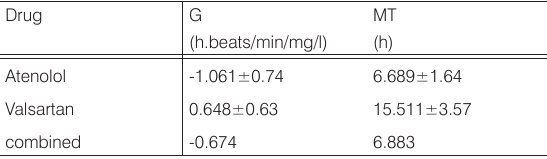
Table 7. The parameters of PD system for SP after separate and combined administration of atenolol and valsartan. Drug G